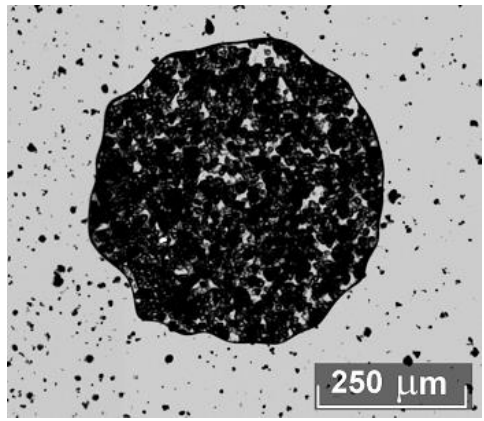
Figure 10. The second phase with incoherent boundaries formed in a crystal LiNbO 3 :Zn ([ZnO] ≈ 3.95 mol.% in a crystal). Z-cut. Crystals 2019 , 9 , x FOR PEER REVIEW